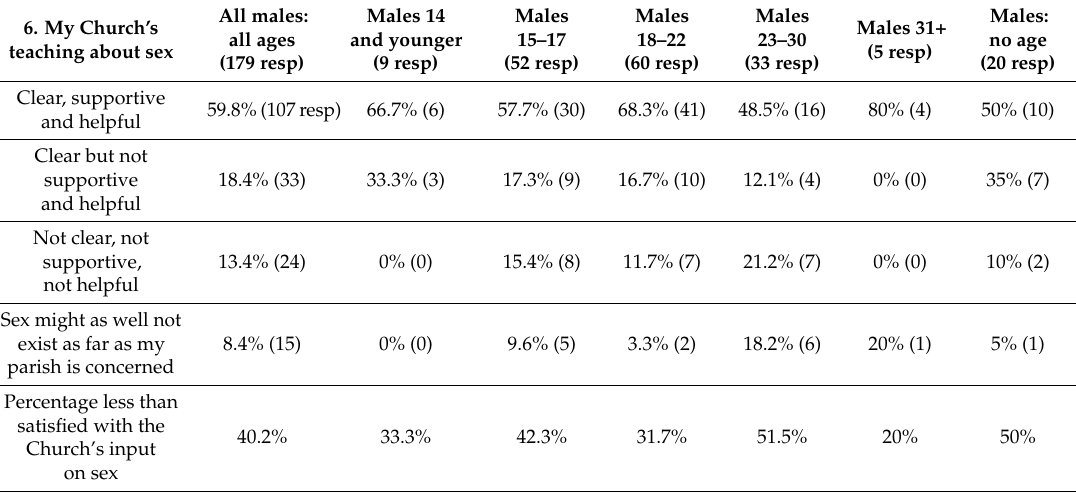
Table 7. Church’s Teaching about Sex—All Males.